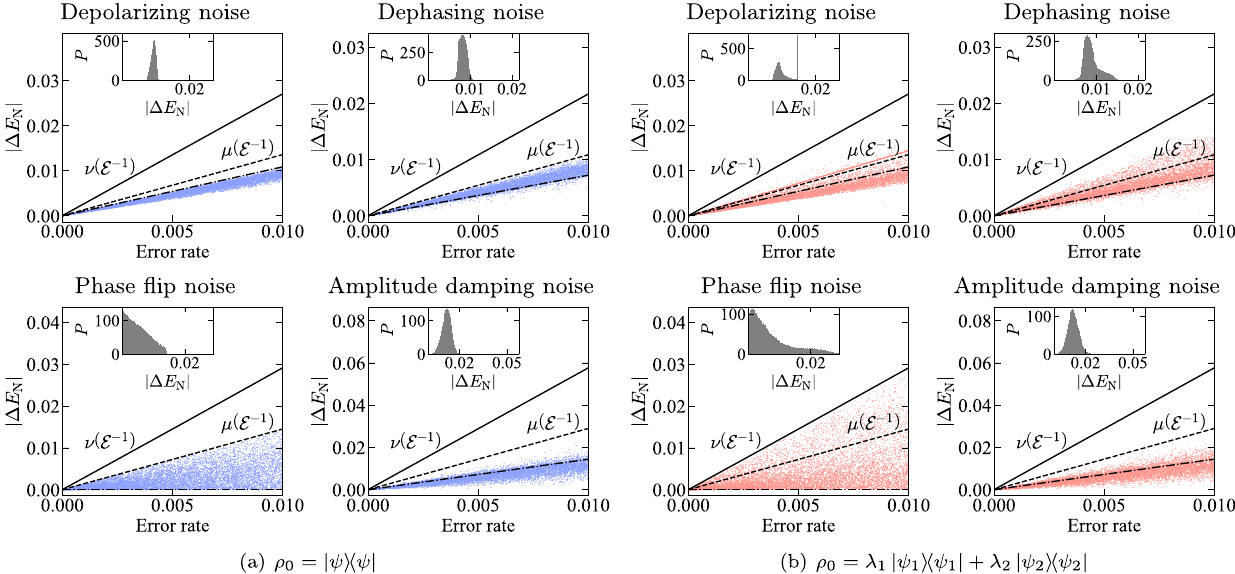
Fig. 1 The change of logarithmic negativity of quantum states Δ E N j j . The input states are randomly chosen as two-qubit a pure states ψ j i ψ h j or b mixture of pure states ρ ρ 0 ¼ To benchmark, we plot the upper bounds given by the physical implementability of the noise inverse ν ðE (cid:2) 1 Þ (solid lines), the estimation values given by root-mean-square μ ðE (cid:2) 1 Þ (dashed lines), and the analytical values derived for the maximally entangled state (dash-dot lines). Insets show the probability distributions P of Δ E N j j for error rate ε =